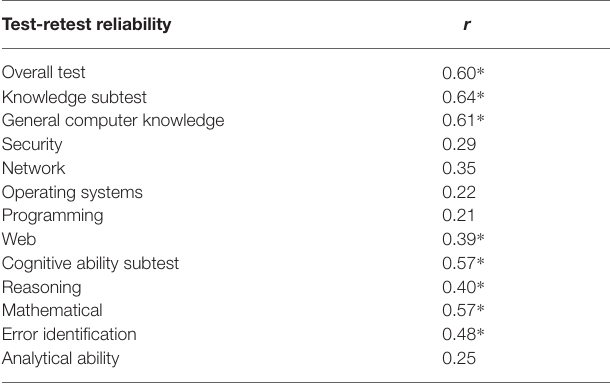
TABLE 5 | Reliability for CTFS overall, the subtests and their